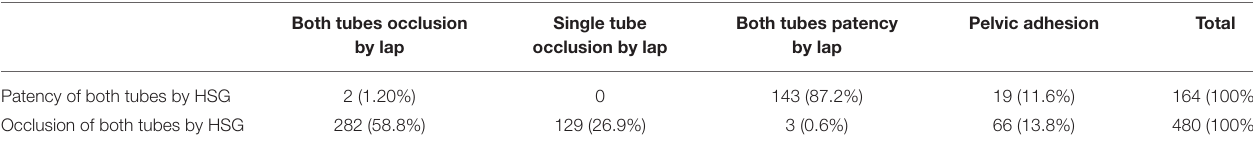
TABLE 3 | The relationship between the diagnosis of patency (or occlusion) of both tubes by HSG and by laparoscopy n (%).